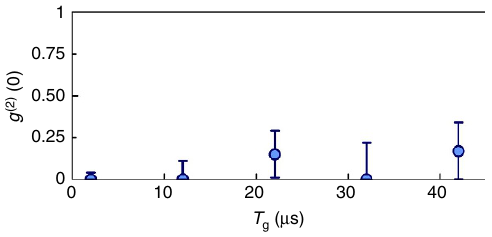
Figure 5 | Non-classical memory dynamics. The single excitation generated with the 70 p 3/2 state is mapped onto the retrieved field after being stored in the ground states memory for a time of T g . The second- order intensity correlation function at zero delay g (2) (0) is measured at different storage times T g . Error bars, ± 1